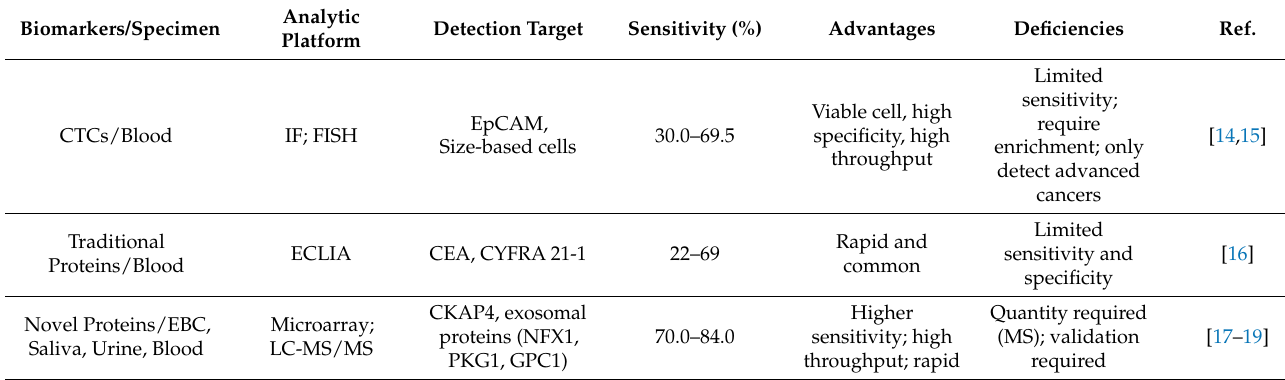
Table 1. Summary of the noninvasive detection methods for lung